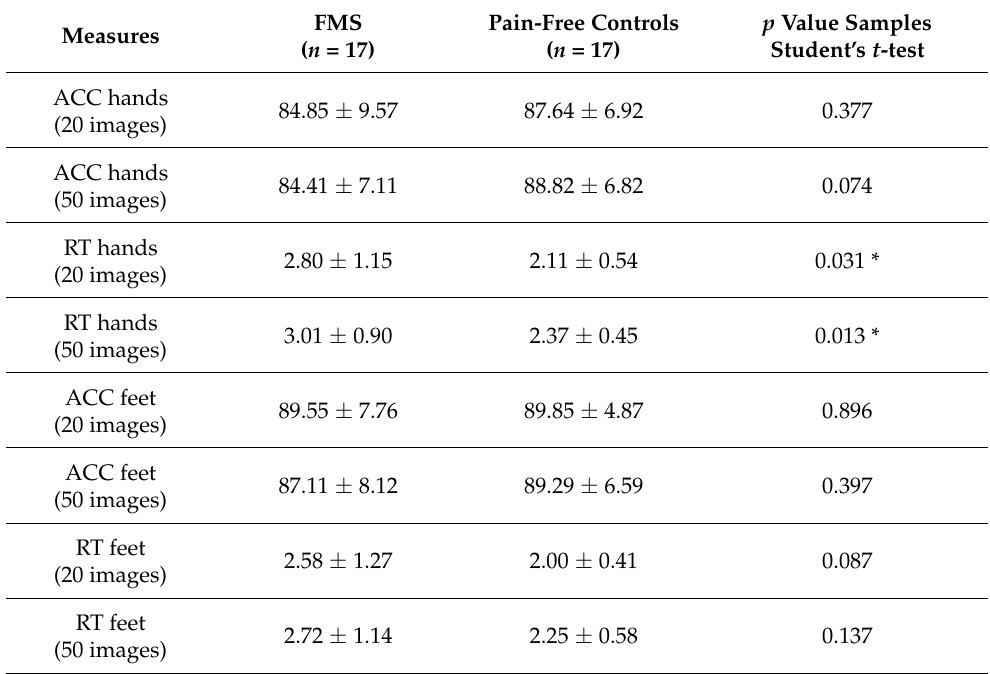
Table 2. Group comparison of right/left judgment performance between FM and pain-free controls.